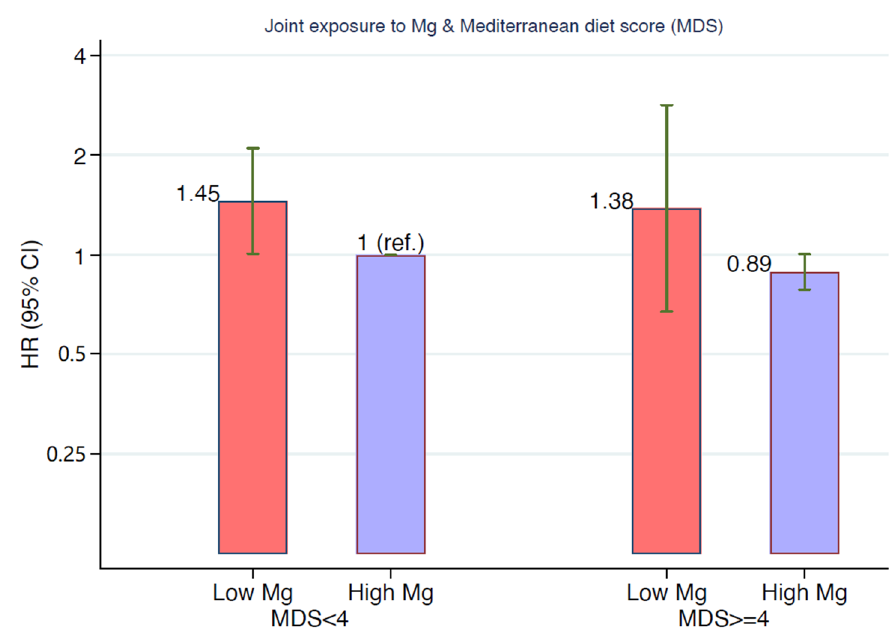
Figure 3. Multivariable-adjusted hazard ratios for incident hypertension. Joint exposure to Medi- terranean diet score (lower and higher than four points) and magnesium intake (lower and